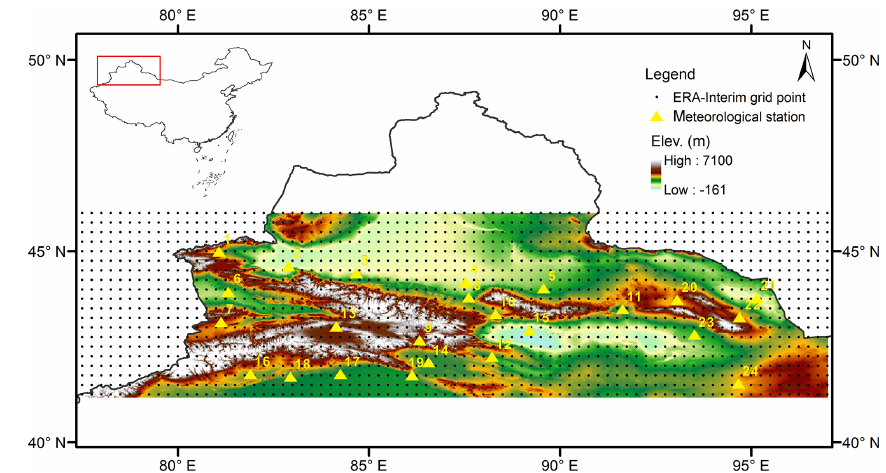
Figure 1. Location of the 24 meteorological stations (triangles) and ERA-Interim 0 . 25 ◦ × 0 . 25 ◦ grid points (dots). The elevation ranges from − 161m to 7100ma.s.l., with a DEM resolution of